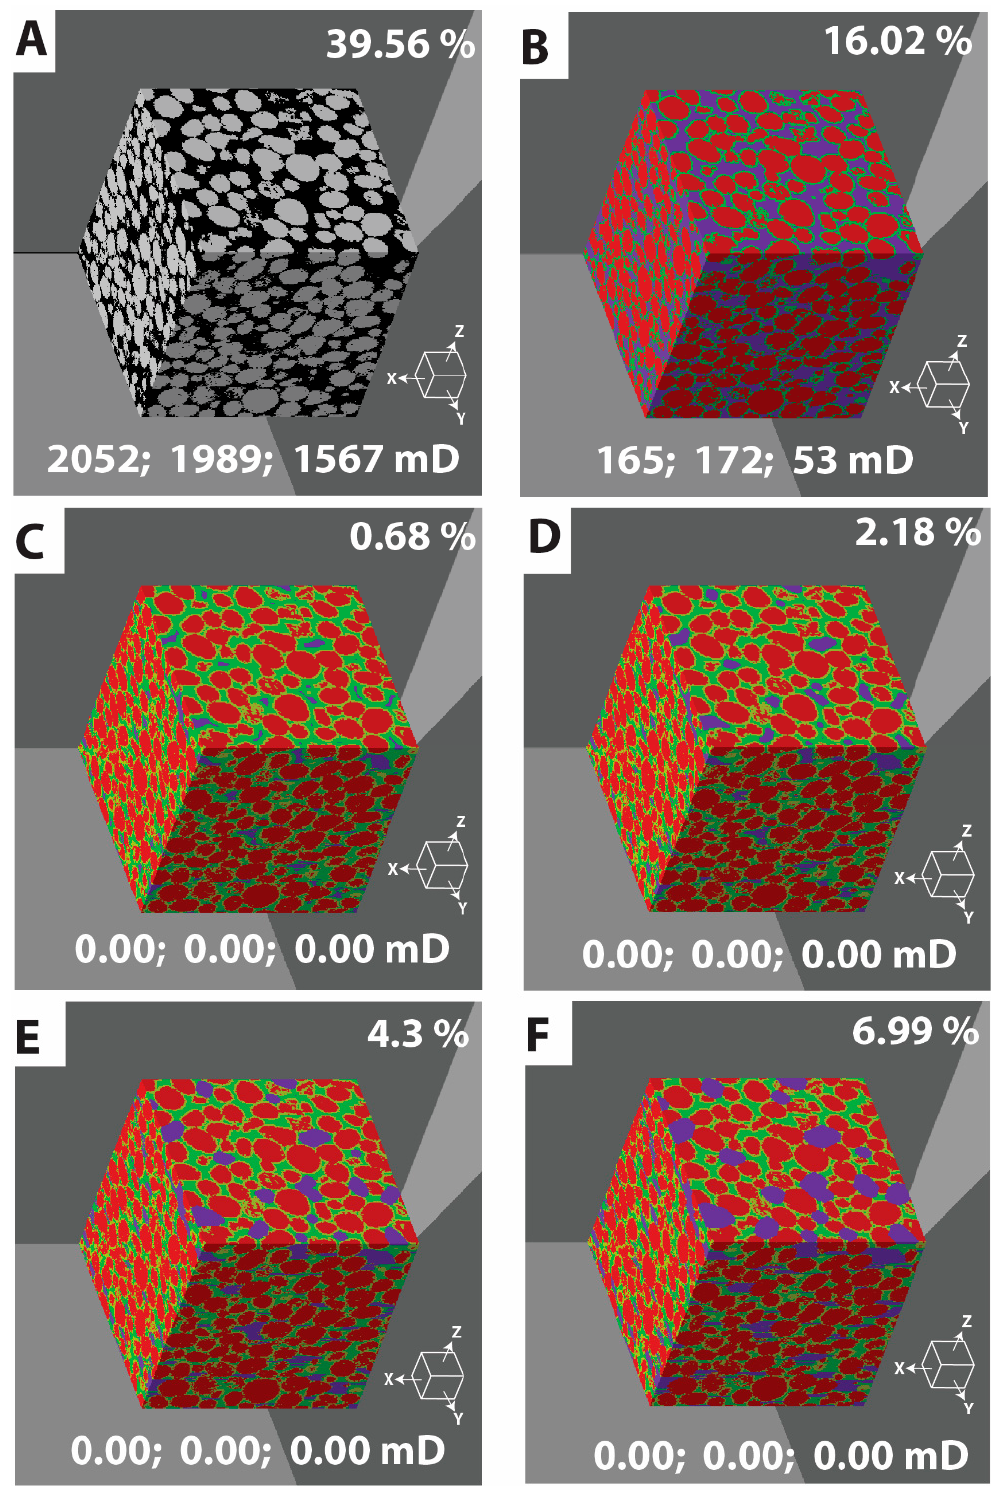
Figure 5. Three-dimensional models of oolitic limestone, developed from an X-ray tomography (XRT) scan of Bahamian ooids. ( A ) Base binary model of carbonate grains (ooids) and interparticle pores; ( B ) and ( C ) colourised grayscale 3D images representing phase 1 (riming) and phase 2 (pore blocking) cements; ( D )–( F ) as in (B), (C), but illustrating progressive pore dissolution. All images also show recorded porosity (top right), and permeability in the X, Y and Z directions (bottom); with results obtained through the use of the PAT software.